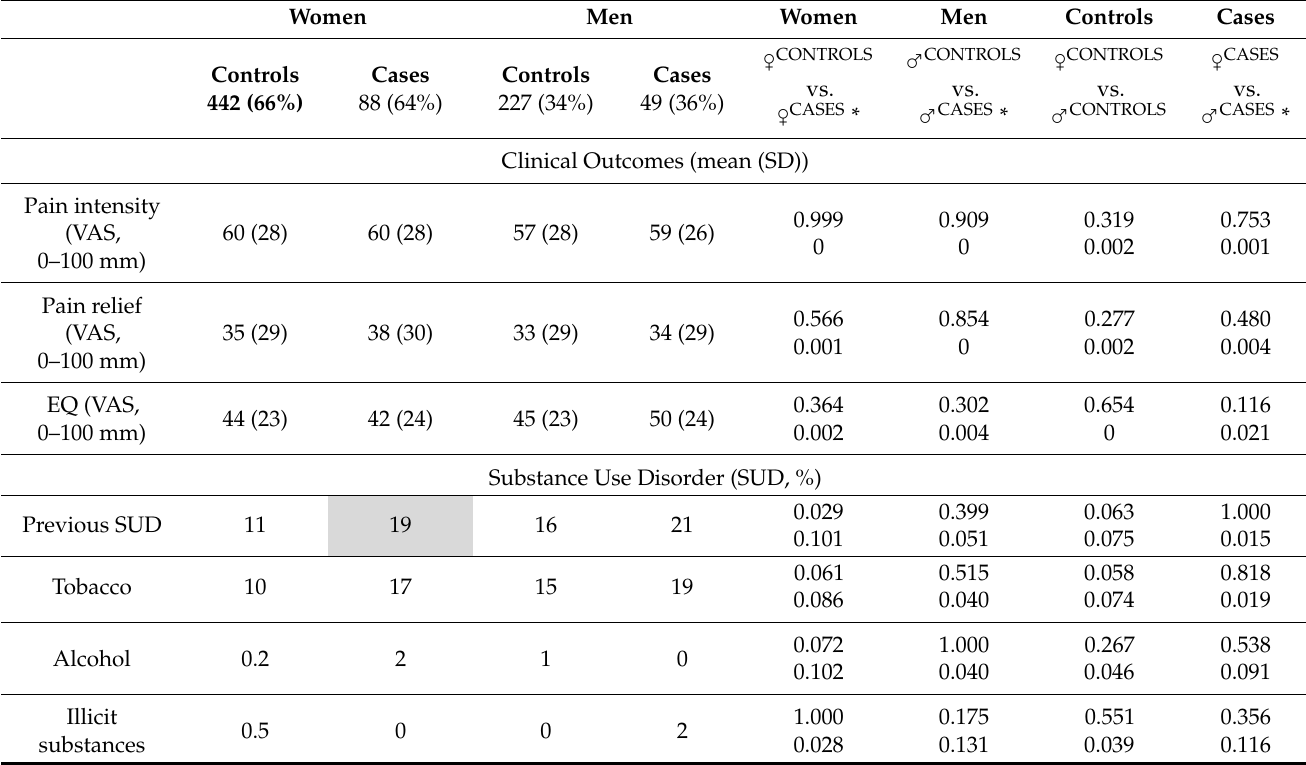
Table 2. Clinical analysis by